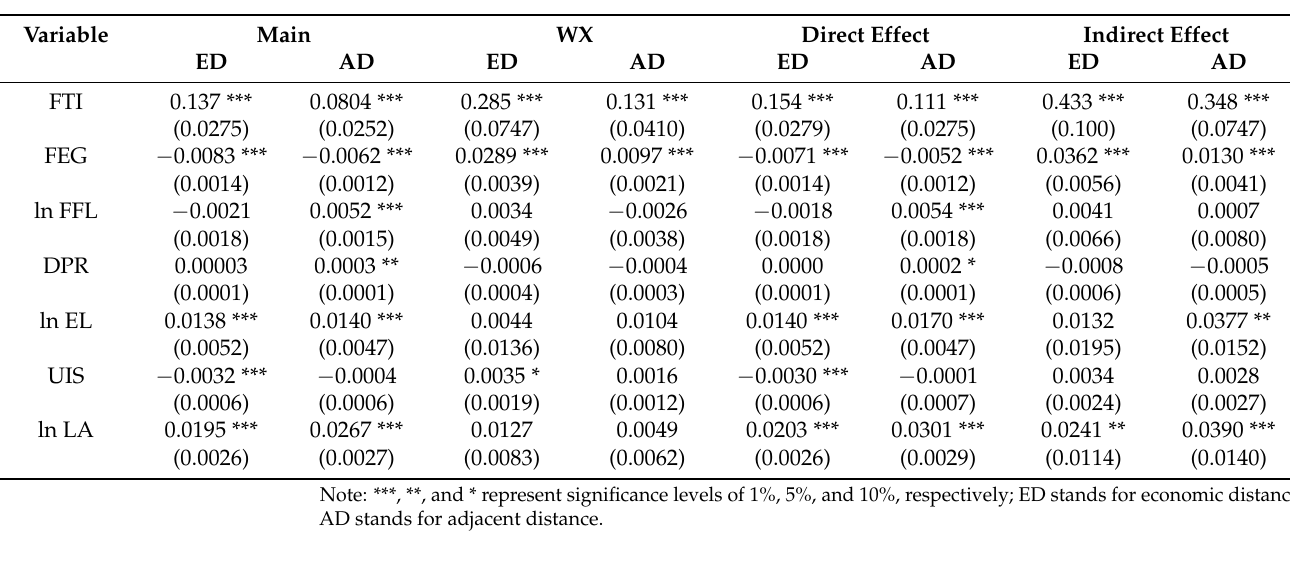
Table 9. Robustness test results for replacing spatial weights.